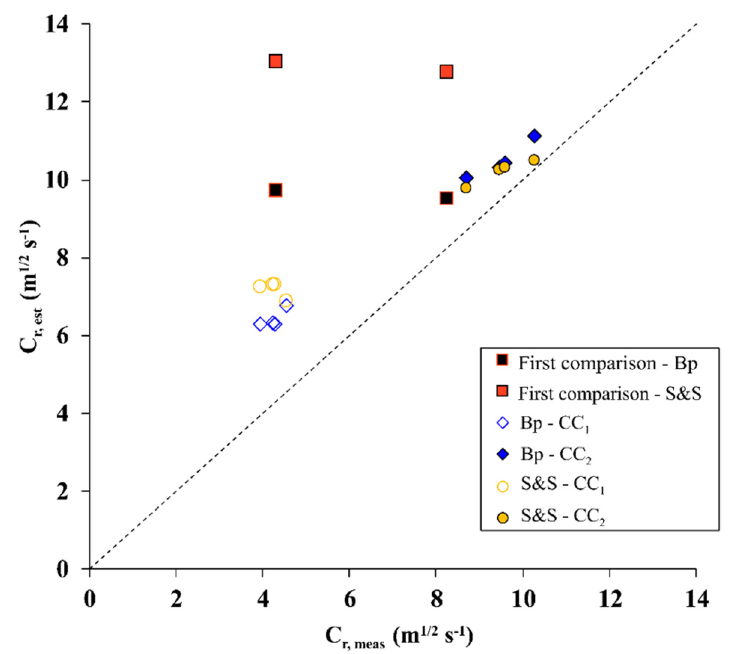
Figure 9. Measured and modeled C r (m 1/2 ·s − 1 ) for the Bp and S&S resistance predictors [8,9], by not applying (black and orange filled squares) and applying the four composite cross section methods: the blue diamonds and the yellow circles correspond respectively to Bp and S&S resistance predictor models, for Q 2 = 0.16 m 3 ·s − 1 (unfilled symbols) and Q 3 = 0.33 m 3 ·s − 1 (filled symbols). The dashed black line represents the perfect agreement between modeled and measured C r .